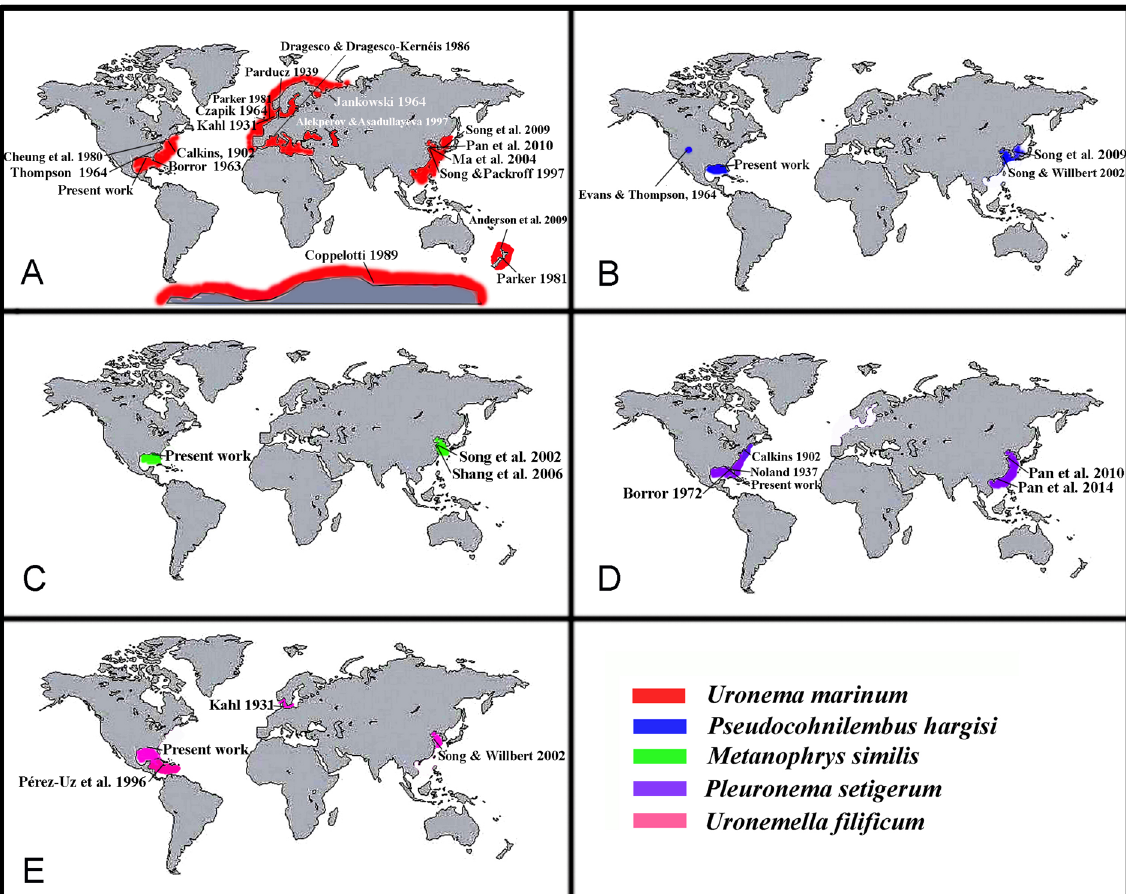
Fig. 5. All reported populations for the following species. A . Uronema marinum Dujardin, 1841. B . Pseudocohnilembus hargisi Evans & Thompson, 1964. C . Metanophrys similis Song et al. , 2002. D . Pleuronema setigerum Calkins, 1902. E . Uronemita filificum